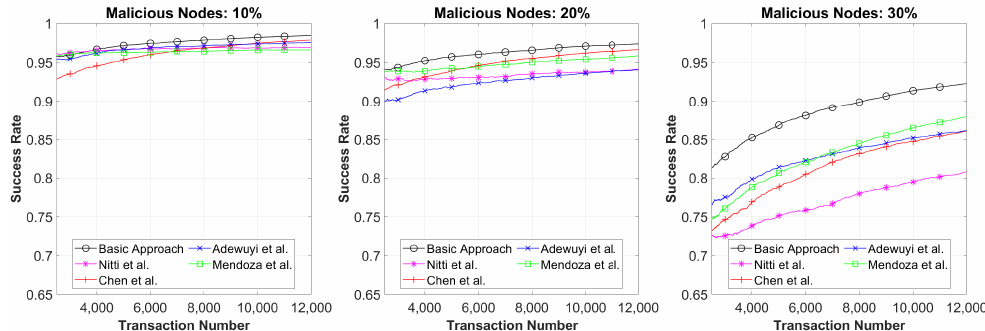
Figure 3. Transaction success rate for different trust management models for the ME attack at varying percentages of the malicious